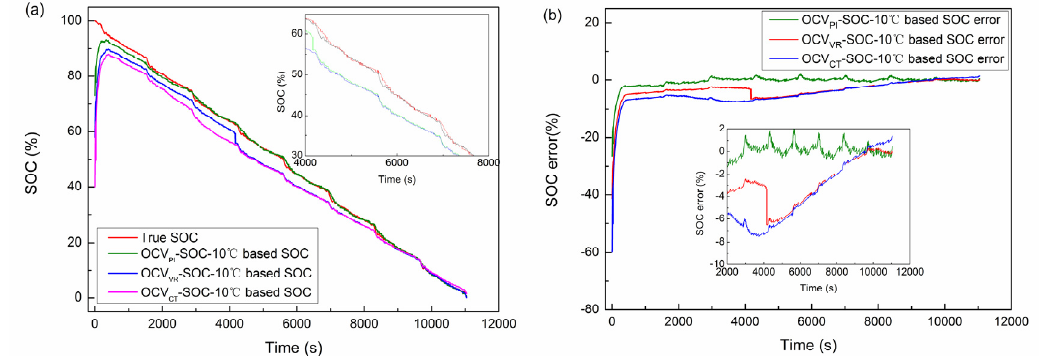
Figure 26. Estimated comparison using the three different OCV–SOC–T relationship maps in the FUDS test at 20 °C: ( a ) SOC and ( b ) SOC error.